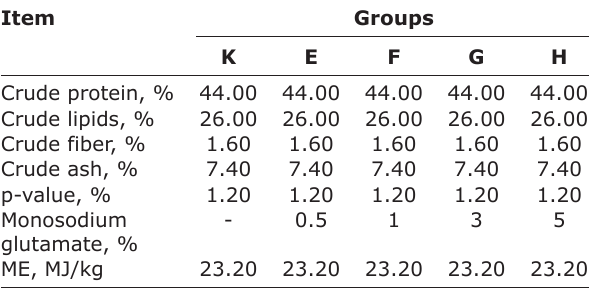
Table-1: Nutrient content in extruded feed for rainbow trouts ( Oncorhynchus mykiss W.). Item